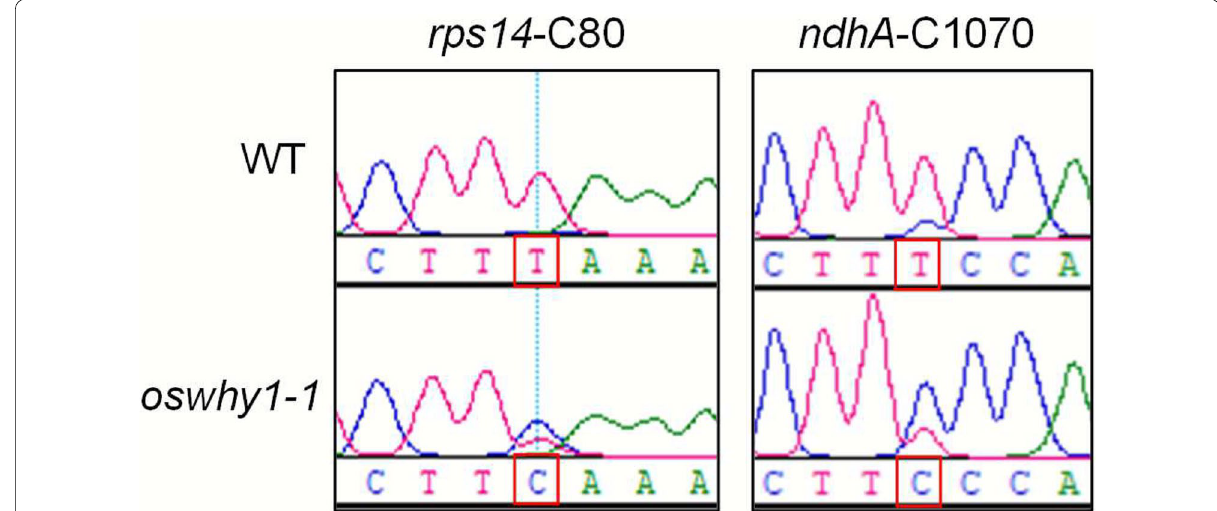
Fig. 6 OsWHY1 affects chloroplast RNA editing sites ndhA and rps14. Two plastid genes and the corresponding two editing sites were not normally edited in the oswhy1-1 mutant. The red boxes indicate RNA editing sites (T) in the WT and non-editing sites (C) in the